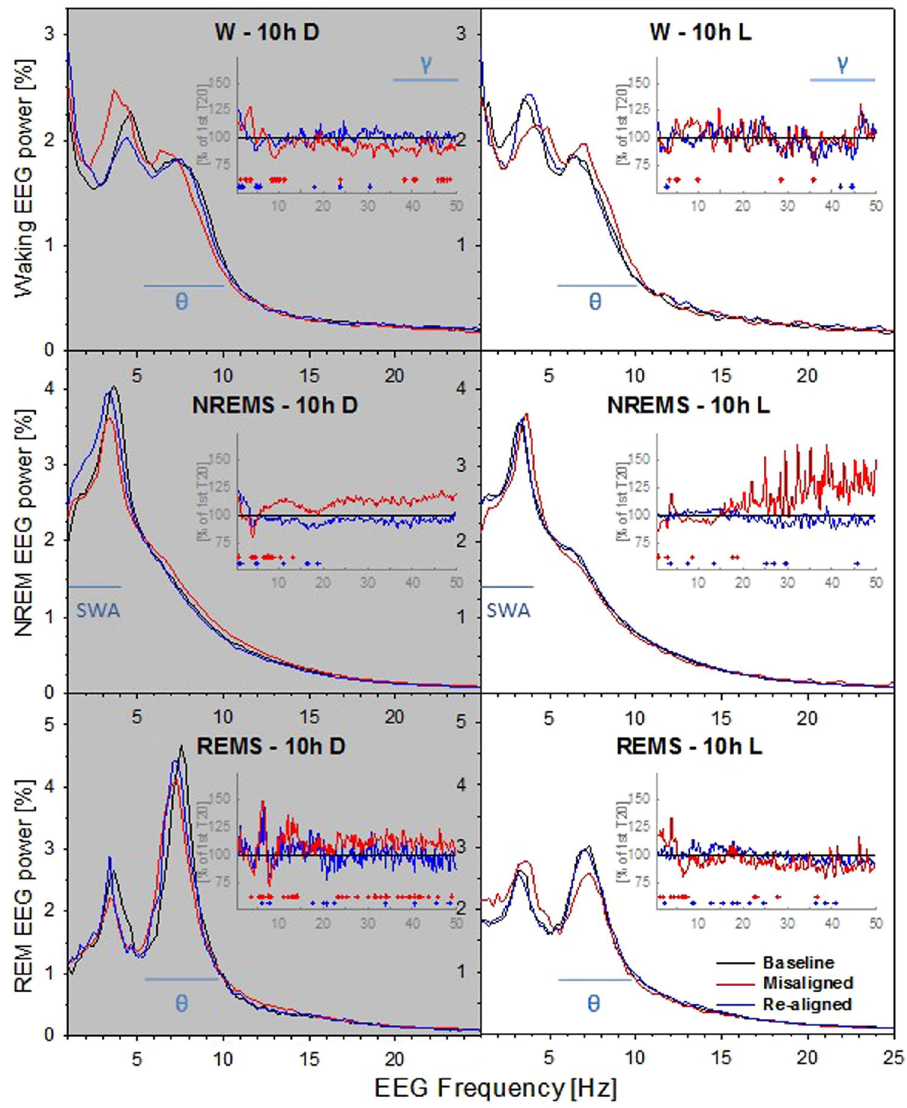
Figure 4. EEG spectral profiles under different T20 conditions during the 10-h dark (D - left ) and 10-h light (L - right ) phases, and averaged for all 10-s epochs scored as wakefulness (W - top ), NREM sleep (NREMS - middle ), or REM sleep (REMS - bottom ). Average EEG spectra are normalized to total EEG power [%] over the entire 10-h dark ( left ), or 10-h light ( right ) phase. Note that for optimal viewing of the lower frequencies ( < 10 Hz) such as theta dynamic, the hertz scale (x-axis) in the main graphs is only displayed up to 25 Hz (instead of 50 Hz). The inset graphs illustrate the spectral differences as percent change for the misaligned (red line) and re-aligned (blue line) T20 cycles versus the baseline T20 cycle ( = 100%; B6: n = 5). Significant T20 differences are indicated by red (misaligned vs. baseline T20) and blue (re-aligned vs. baseline T20) crosshairs ( P < 0.05, paired t- tests) at the bottom of each inset. Some specific EEG bands are denoted by the horizontal blue lines. SWA (slow wave activity: 1–4 Hz), θ (theta: 5.5–10 Hz) and γ (gamma: 35–50